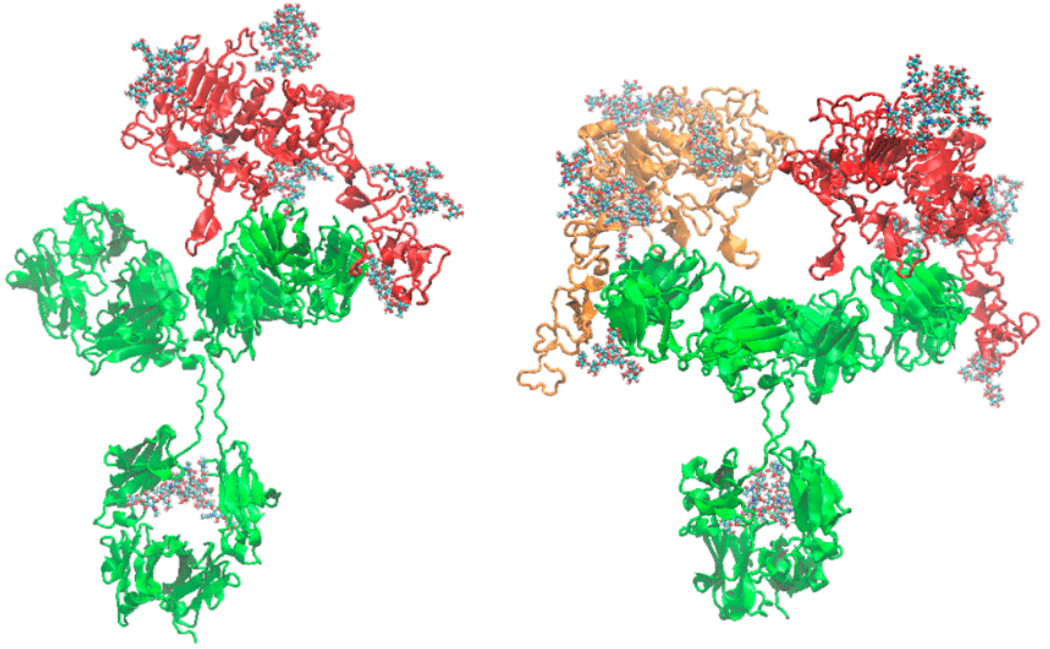
Figure 5. Cartoon representation of representative equilibrated conformations for the 1:1 (left) and 1:2 (right) complexes. The TZM antibody protein is represented in green and the g-eHER2-his in red and orange colors. The glycans are represented as CPK models. PDB files of these structures can be found in the supporting material.